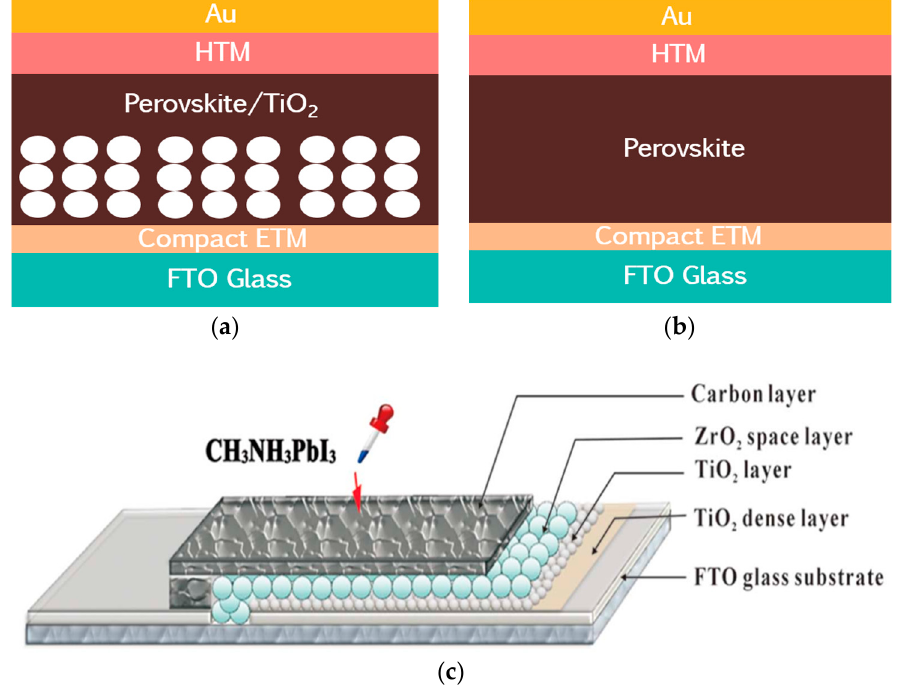
Figure 2. ( a ) Mesoporous perovskite solar cell (PSC); ( b ) Planar heterojunction PSC; ( c ) Monolithic hole-conductor-free PSC [13].